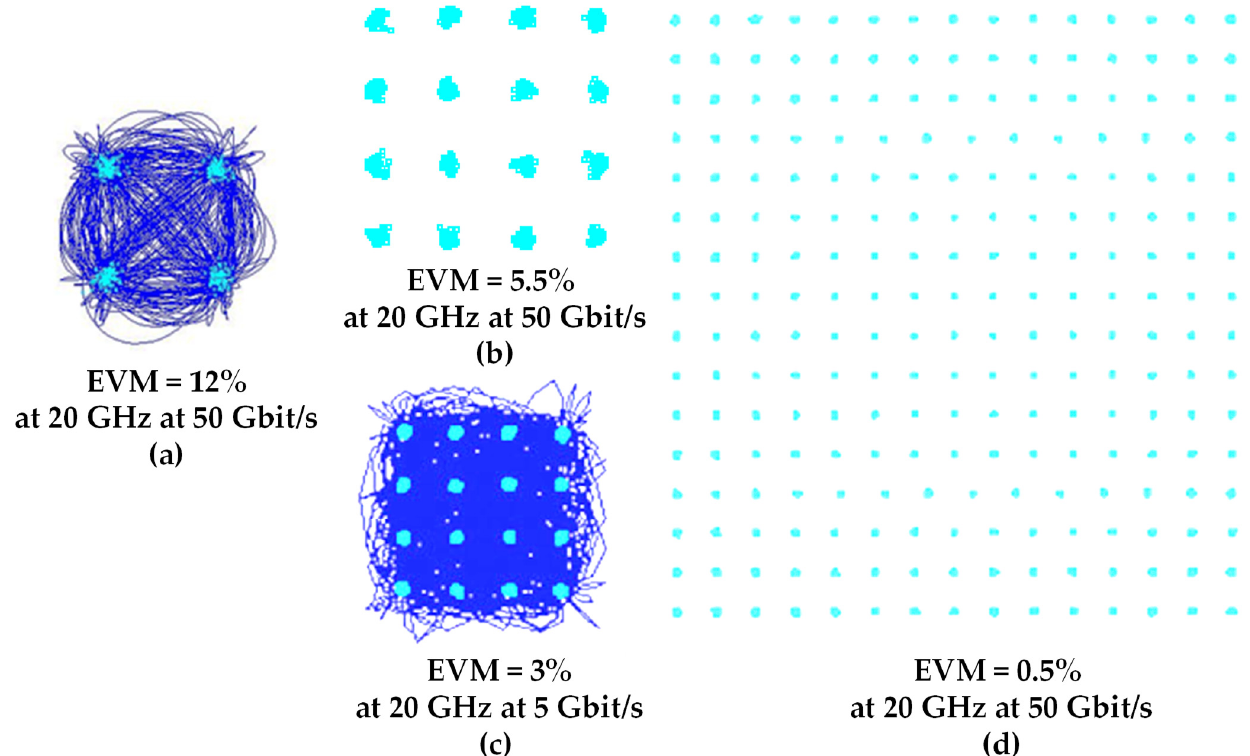
Figure 13. Experimental EVM values versus the harmonic frequency for the “AND” signal at symbol rate of 25 Gbit/s in the case of 4-, 16-, and 256-QAM modulations. QPSK: Quadrature Phase Shift Keying.